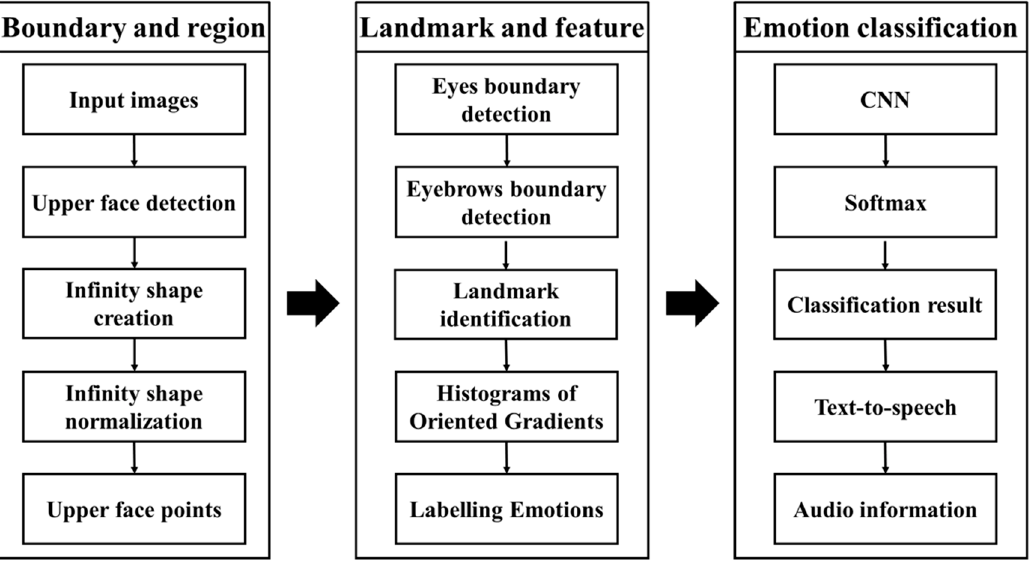
Figure 7. The general process of the proposed facial emotion recognition approach.